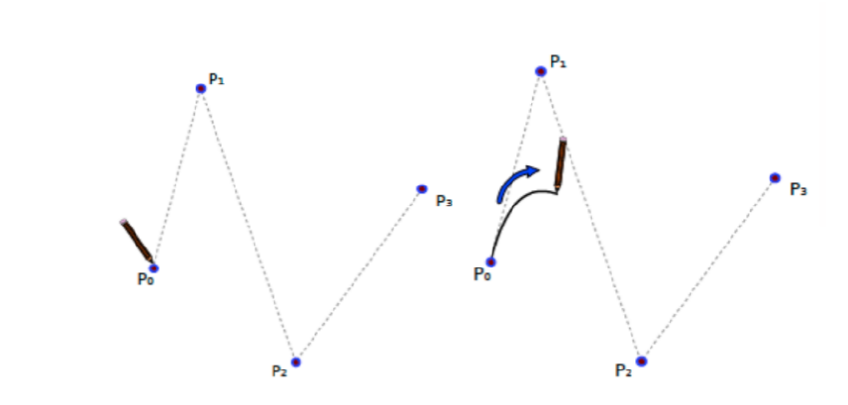
Fig. 2 The correlation between the mathematical curve and the part